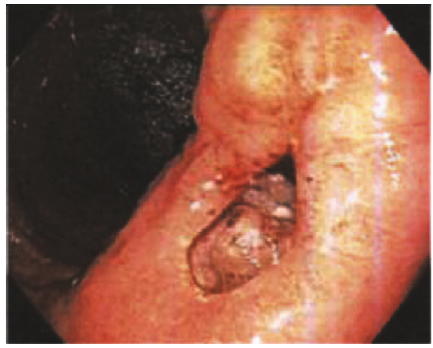
Figure 2: Cigarette lighter seen on endoscopy and removed via polypectomy snare.